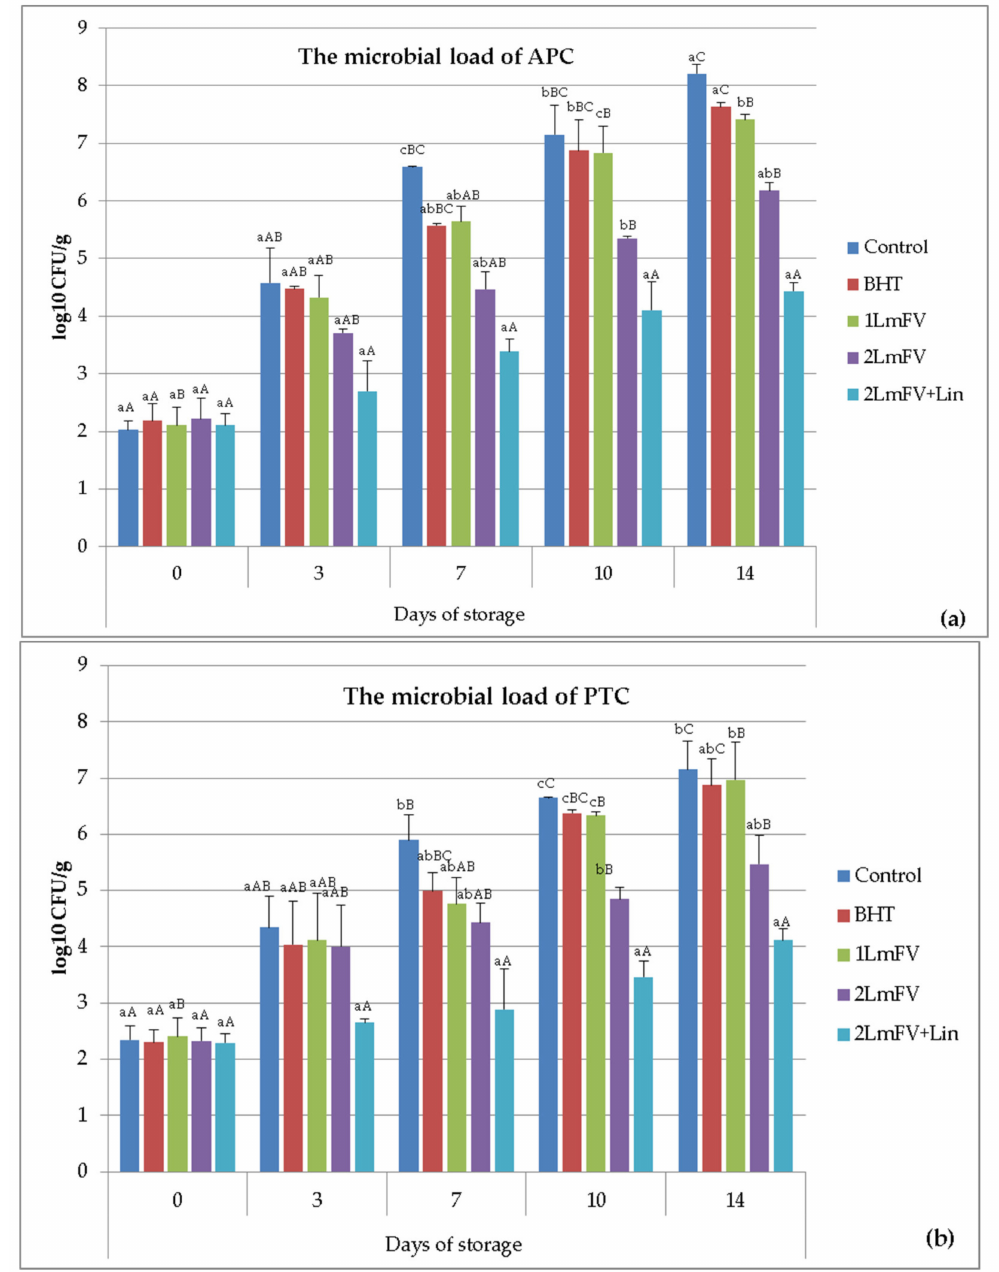
Figure 3. Effect of BHT, 1 Lm FV, 2 Lm FV, and 2 Lm FV+Lin on the microbial load of APC ( a ) and PTC ( b ) (log CFU/g) of raw minced meat samples stored at 4 ◦ C for 14 days; means ± SEMs (n = 3). Values with a different letter (a–c) for the same storage day are significantly different ( p < 0.05). Values with a different letter (A–C) for the same concentration are significantly